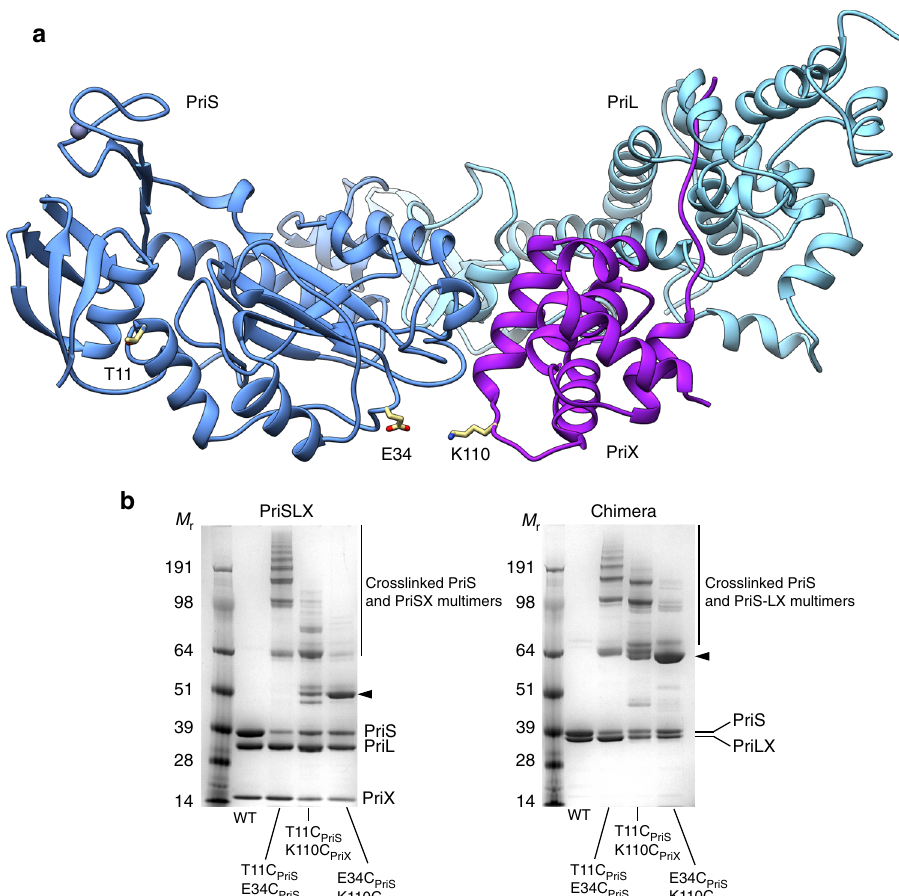
Fig. 7 Structure-based cross-linking of PriSLX. a Ribbon diagram of PriSLX. The side chains of PriS E34 and PriX K110, that were targeted for cysteine mutagenesis, are drawn in stick representation at the PriS – PriX interface. The side chain of PriS T11, that was used as control in the cross-linking reactions, is also shown. b BMOE cross-linking of PriSLX and Chimera PriS E34C, PriX K110C double mutants. The PriS T11C, E34C and PriS T11C, PriX K110C double mutants were used as controls. The products of the cross-linking reactions were separated by SDS-PAGE and stained with Coomassie Blue. The arrowheads mark the product of the speci fi c cross-linking between PriS E34 and PriX